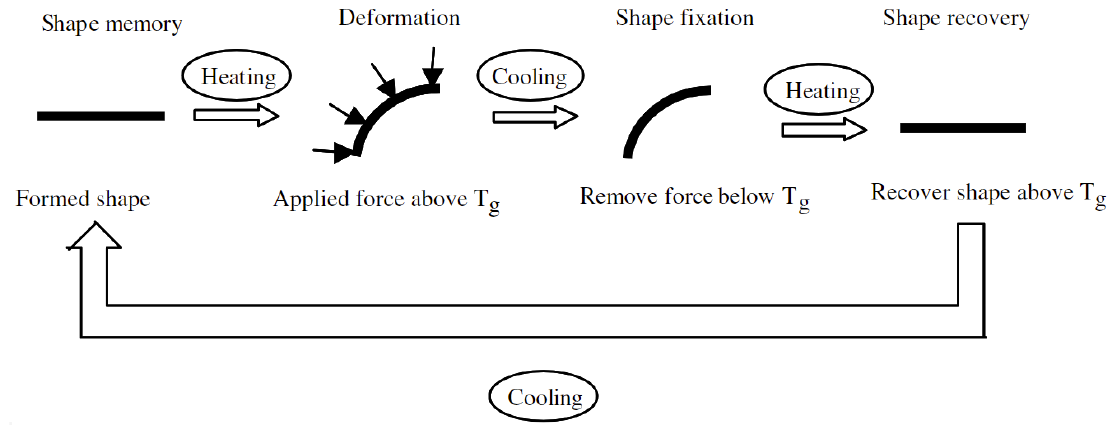
Figure 3. Schematic working principle of shape memory polymers [52].